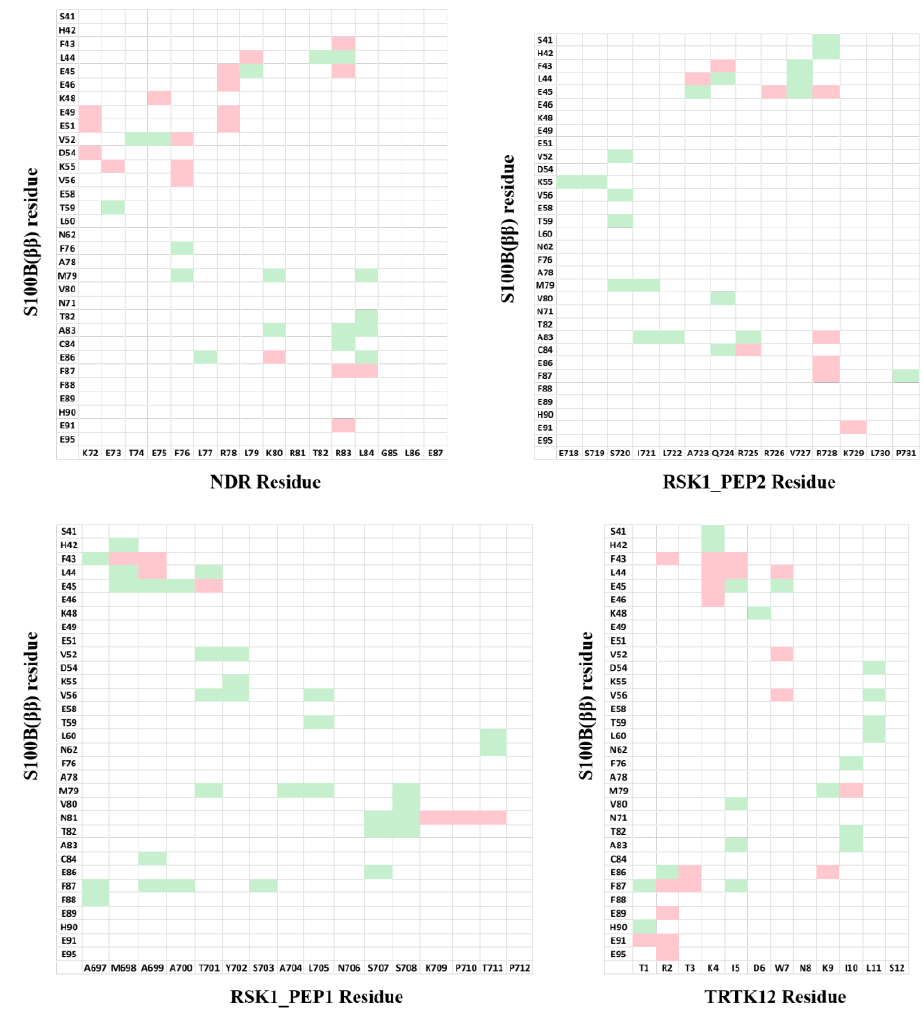
Figure 5. Pairwise residue decomposition of the binding energies of the S100B( ββ )-peptide complexes. The pairwise residue contributions were calculated with the MMPBSA approach (see Methods) using the conformations sampled during the MD simulations. Residue pairs that contribute favourably (green: 1 to 2.5 kcal/mol; red > 2.5 kcal/mol) to the interactions are highlighted.